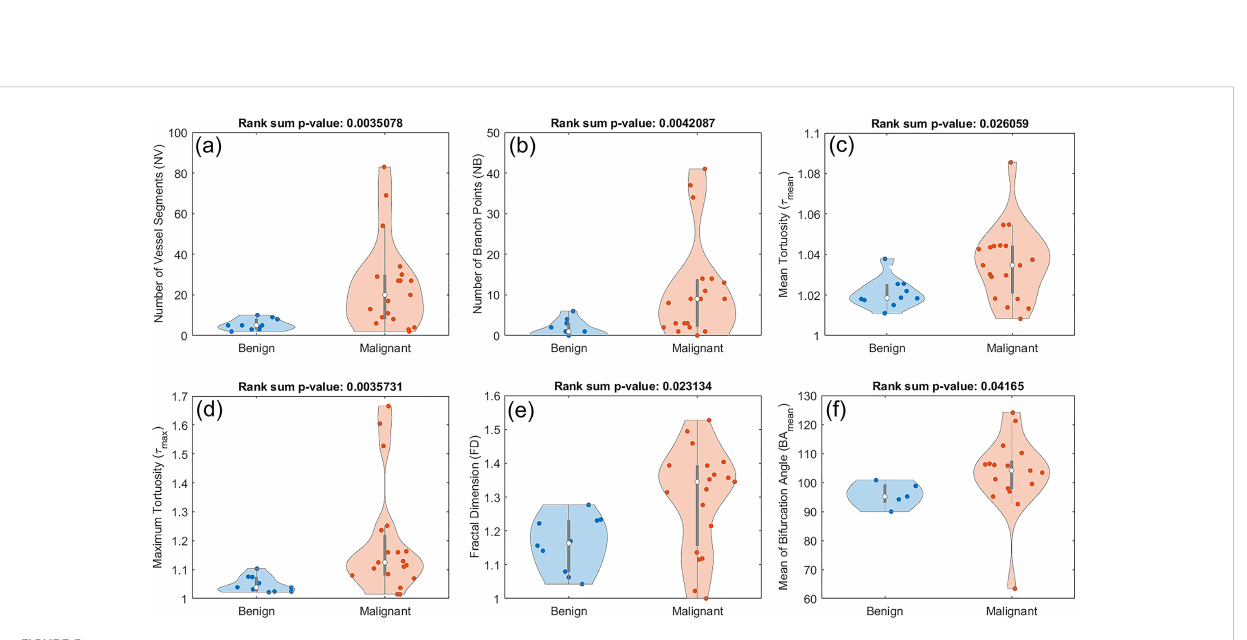
FIGURE 5 Composite boxplot/violin plots of distributions of features that exhibited statistically signi fi cant difference between benign and malignant lesions. (A) Number of vessel segments ( NV ) (B) Number of branch points ( NB ) (C) Mean tortuosity ( t mean ) (D) Maximum tortuosity ( t max ). (E) Fractal dimension ( FD ) (F) Mean of bifurcation angle ( BA mean